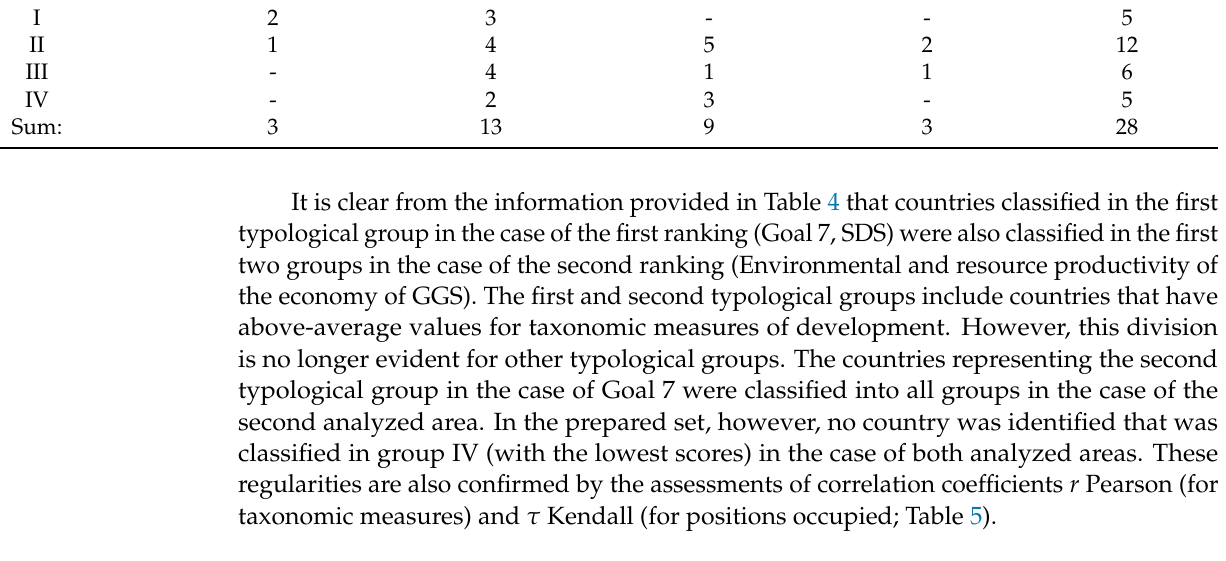
Table 4. EU countries’ development model in the areas of Goal 7 of SDS and the environmental and resource productivity of the economy of GGS. Goal 7 of SDS